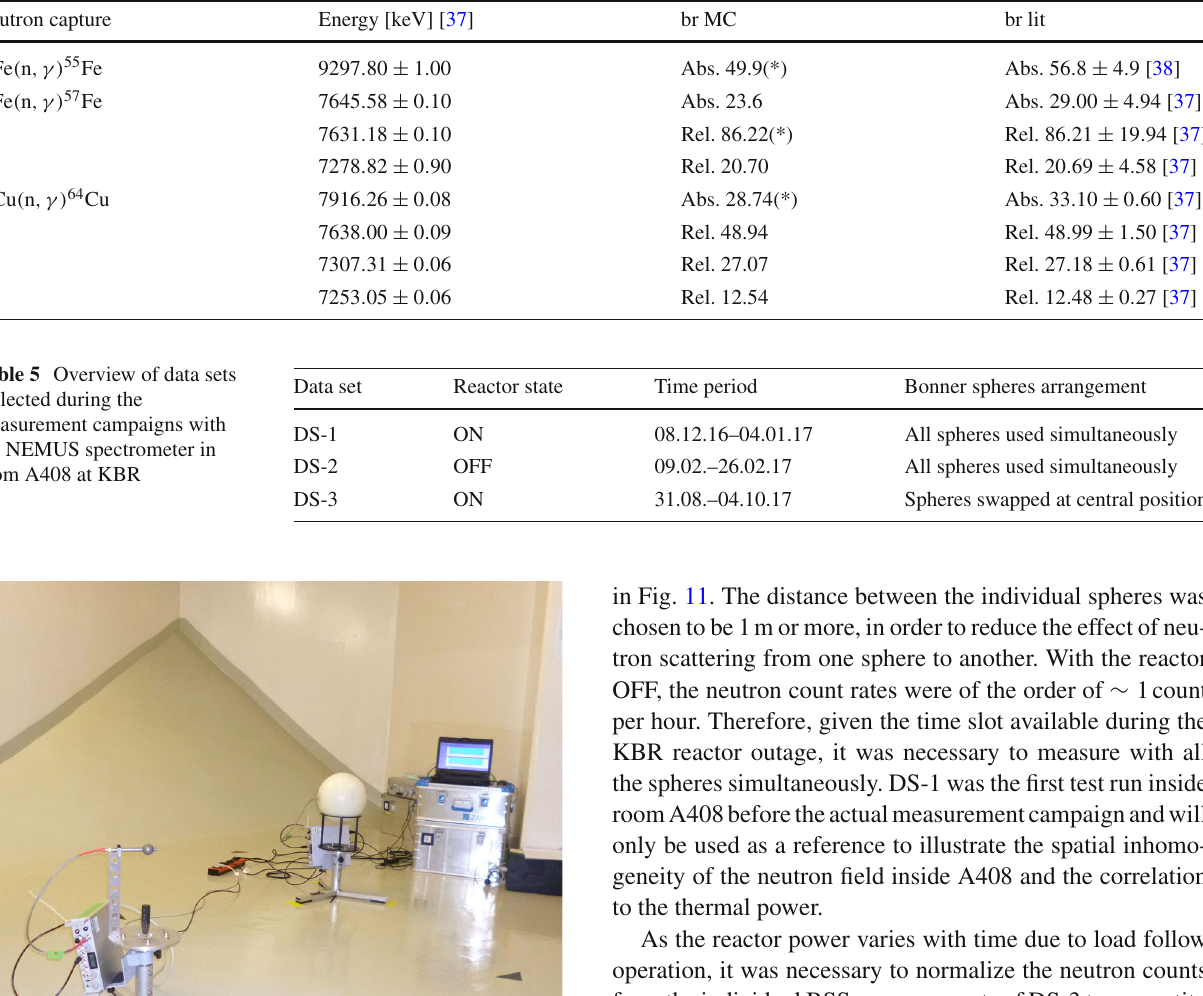
Table 4 The branching ratio (br) in Geant4 of the main γ -lines from neutron capture on the isotopes relevant at KBR are compared with literature values. For the lines marked with (*) the MC generates two neighboring γ -lines close in energy. Out of those one was recognized to